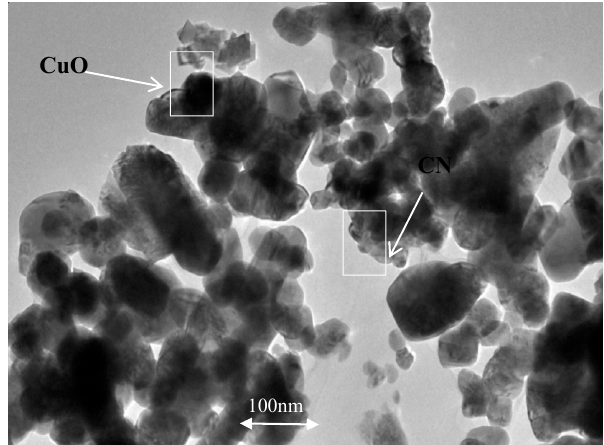
Molecules 2020 , 25 , 2975